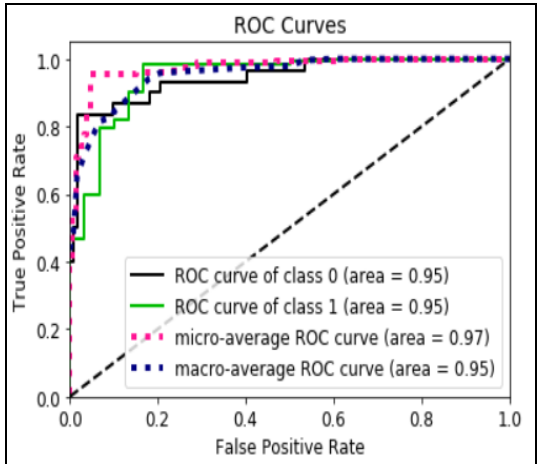
Figure 5. ROC curve of XGBoost using mRMR on all feature subsets